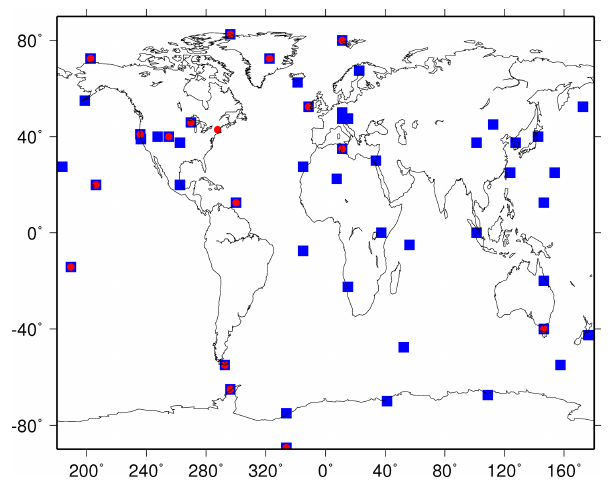
Figure 1. Surface sites from the NOAA, CSIRO, NIWA and EC networks used in this study with red circles for surface sites observ- ing MCF dry air mole fractions and blue squares for surface sites observing CH 4 dry air mole